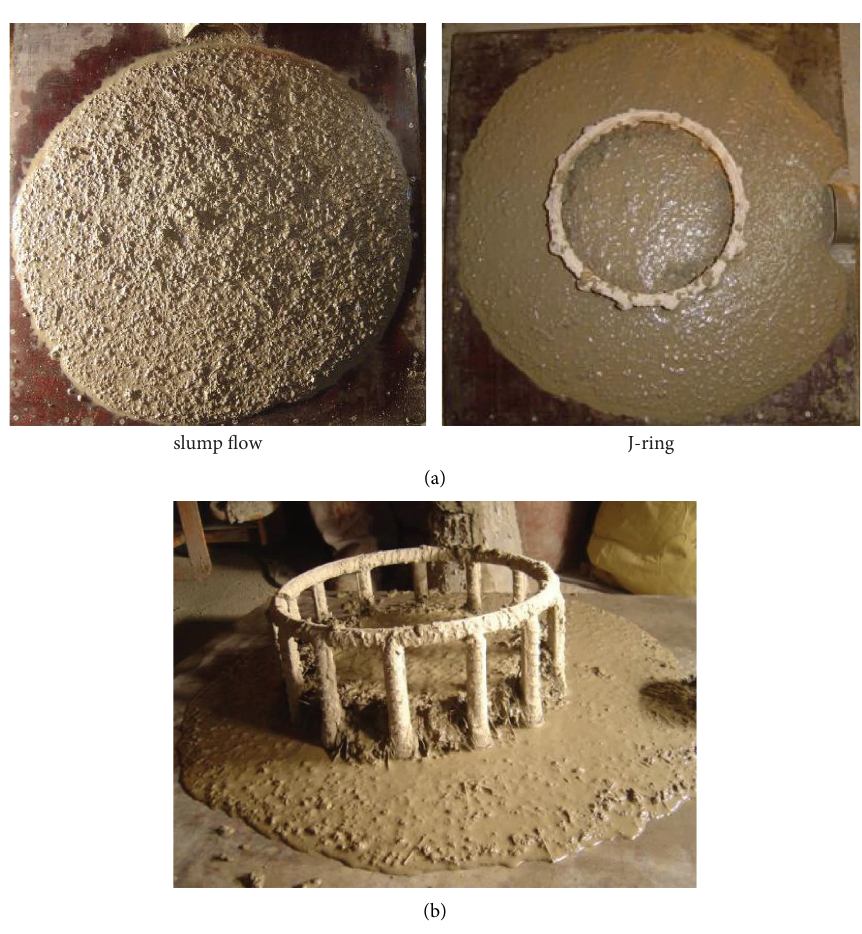
Figure 3: Te workability of self-consolidating concrete with 20kg/m 3 SF+6kg/m 3 PF and 40kg/m 3 SF and 6kg/m 3 PF. (a) SF dosage of 20kg/m 3 and PF dosage of 6 kg/m 3 . (b) J-ring of Self-consolidating concrete with SF dosage of 40kg/m 3 and PF dosage of 6kg/m 3 .